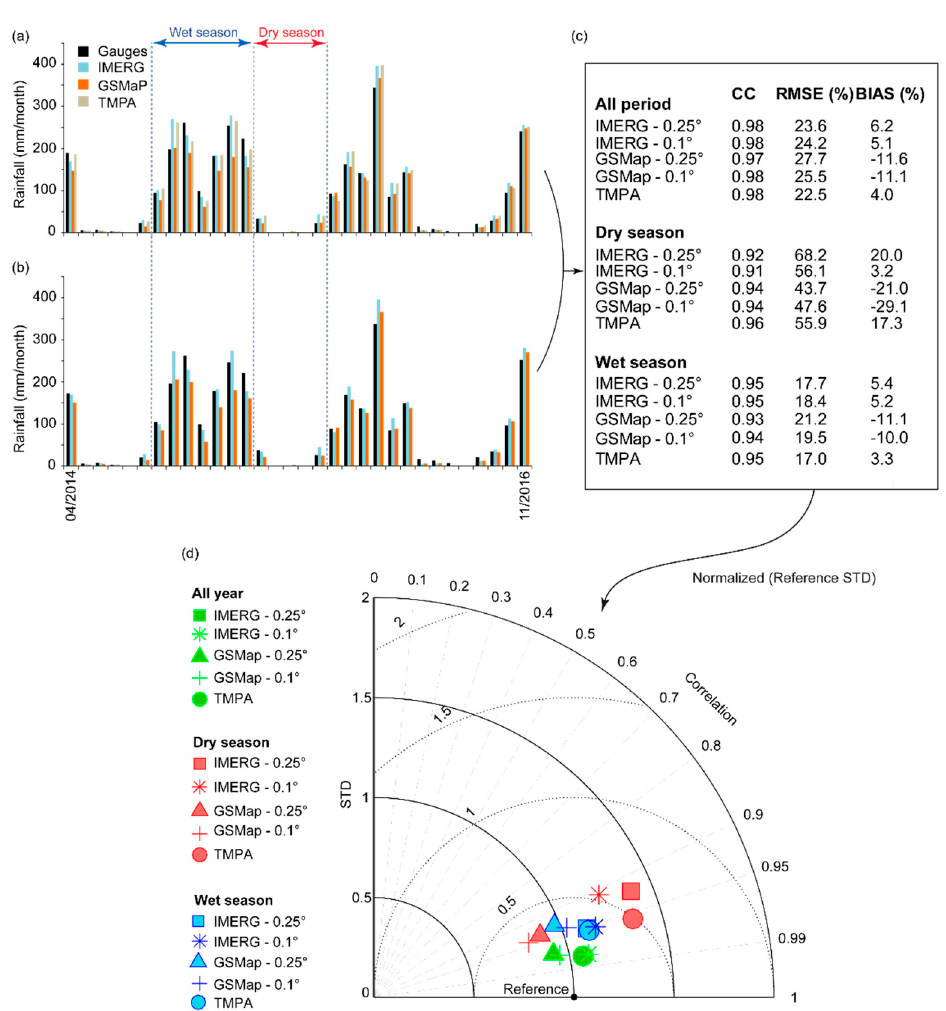
Figure 3. Mean regional monthly precipitation: values from the 0.25° ( a ) and 0.1° ( b ) grids; statistical results ( c ) and the Taylor diagram ( d ).